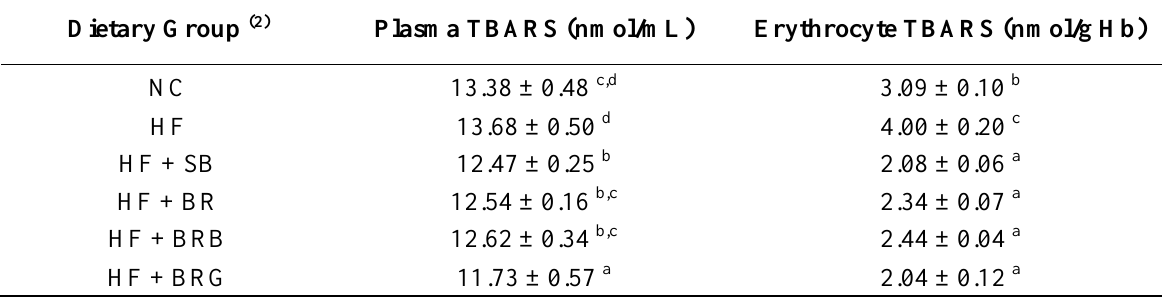
Table 6. Plasma and erythrocyte TBARS levels (1) in mice fed with high fat diet supplemented with rice fermented